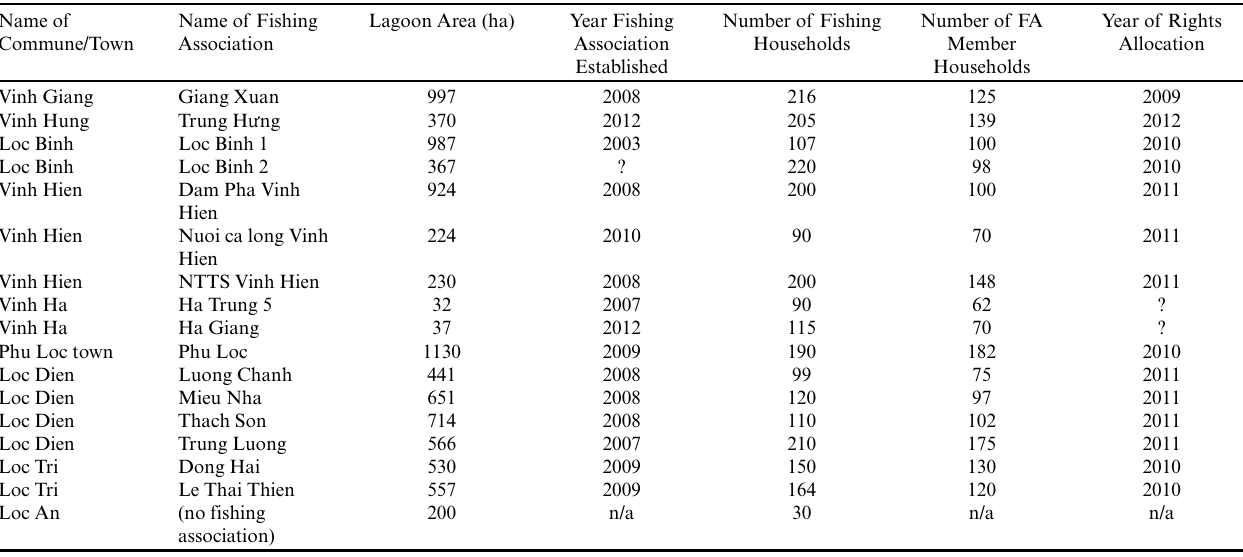
Table 2 . Summary of fishing associations in the Cau Hai lagoon. Main research activities involved Giang Xuan Fishing Association (FA), Loc Binh 1 FA, and Phu Loc FA.